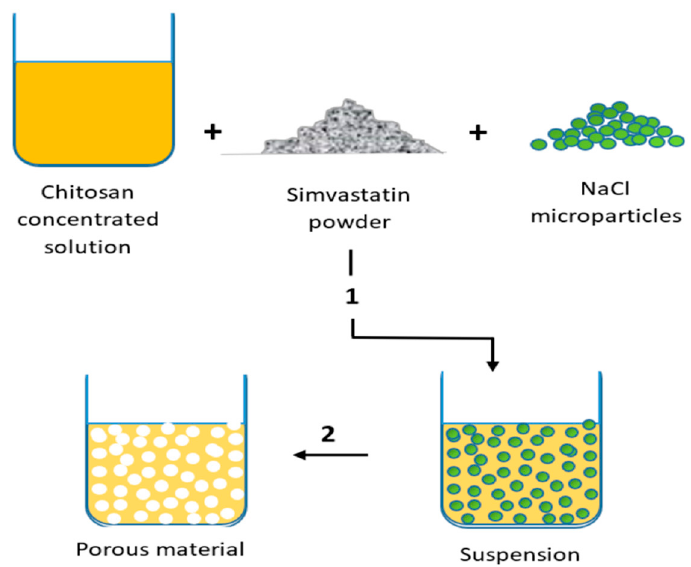
Figure 1. Preparation of porous chitosan/simvastatin scaffold. ( 1 ) Chitosan/simvastatin concentrated solution with NaCL microparticles used as porogens. ( 2 ) Porogen extraction to obtain porous scaffold.